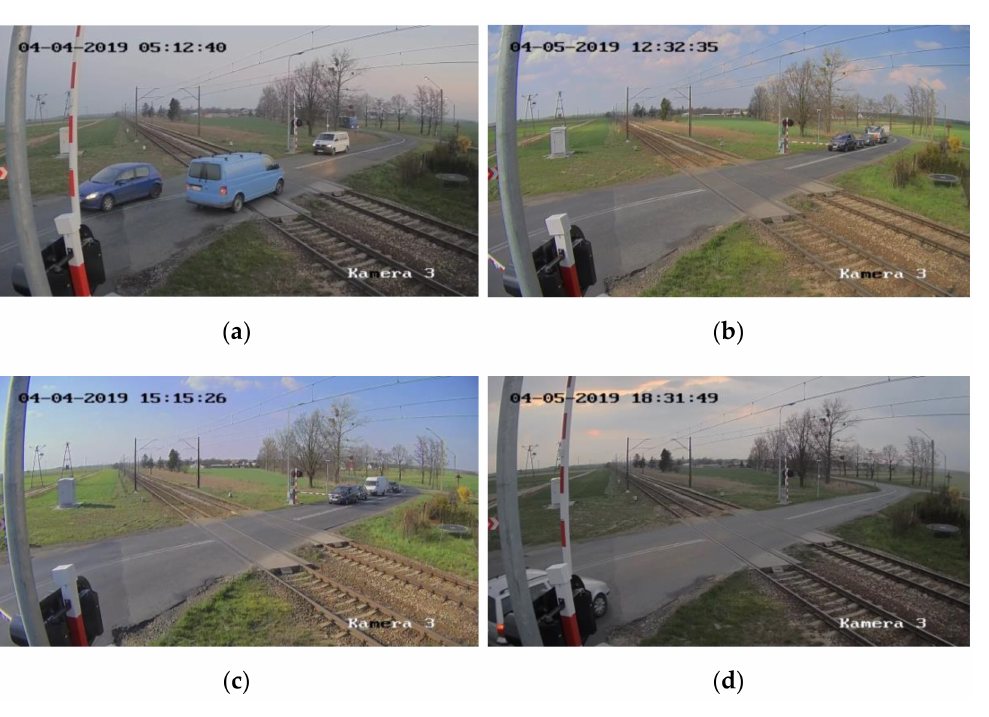
Figure 1. RLC at different times of day: ( a ) morning, ( b ) midday, ( c ) afternoon, ( d ) evening. Two frame sets are prepared: one with objects, cars, passing trains, bicycles and pedestrians, the other with empty area between the gates of the